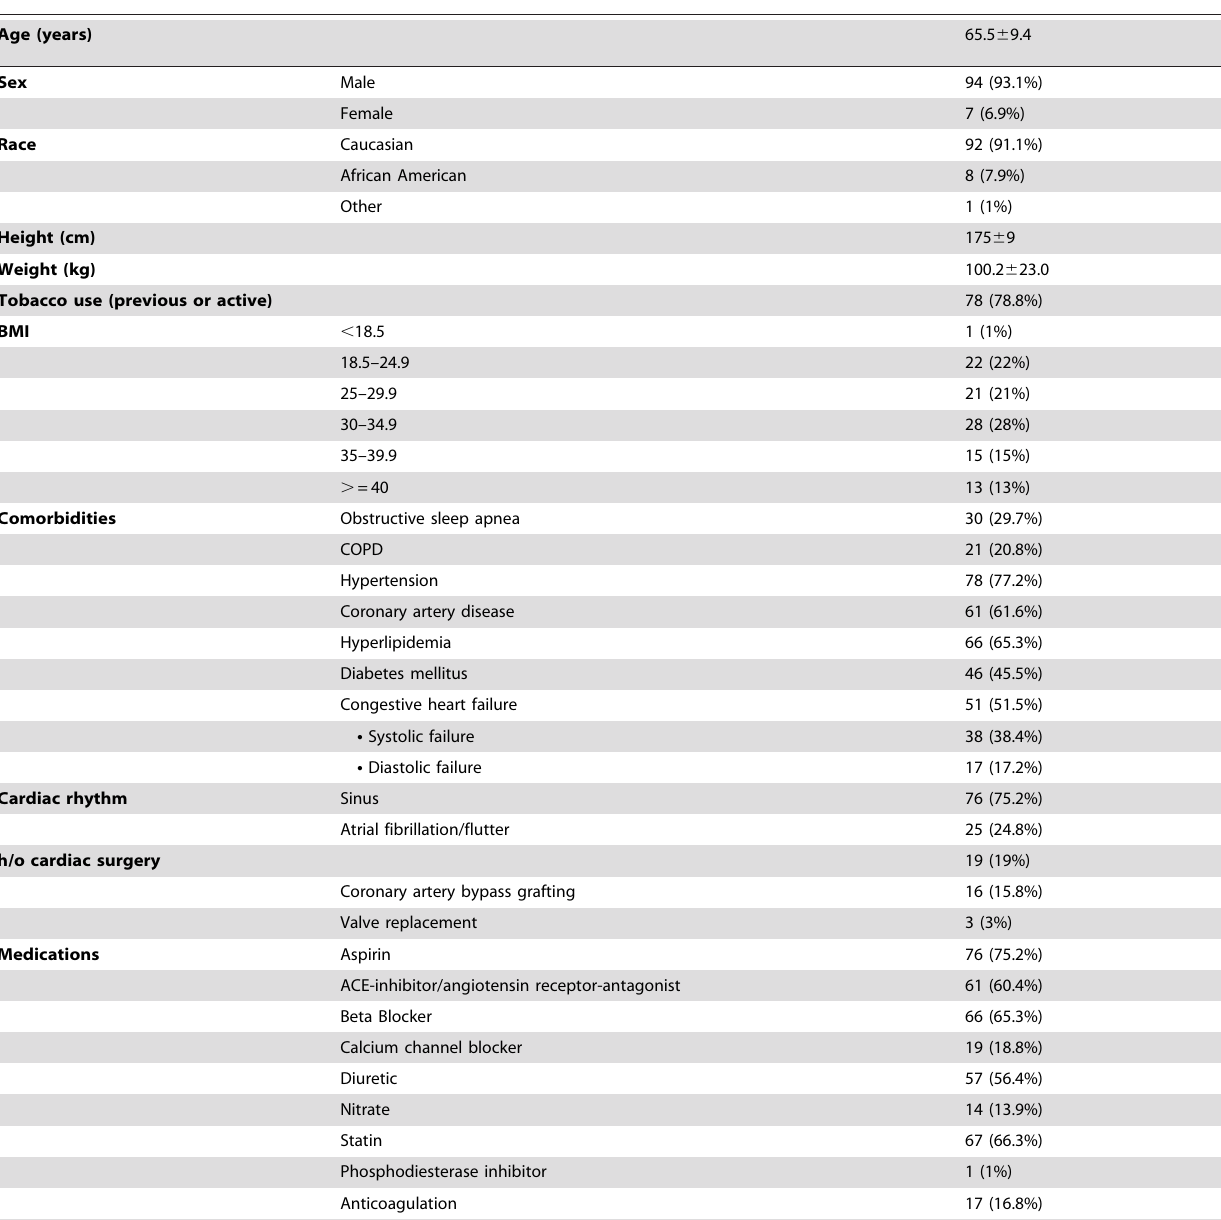
Table 1. Patient characteristics of the 101 study